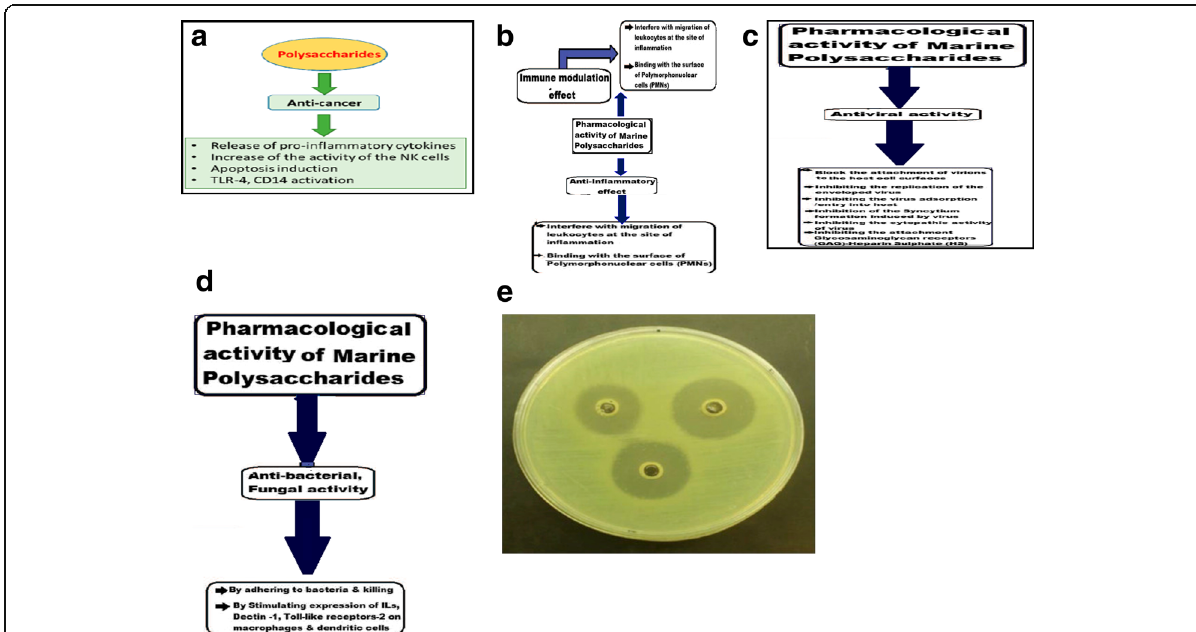
Fig. 2 a Properties of marine polysaccharides and their applications in pharmacology (as anticancer). b the mechanism of action in the drug activity marine PSs (anti-inflammatory effect and immune modulation). c Properties of marine polysaccharides and their applications in pharmacology (as anti-viral). d Properties of marine polysaccharides and their applications in pharmacology (as Antimicrobial). e Inhibition zone of different concentration of EPS against Escherichia